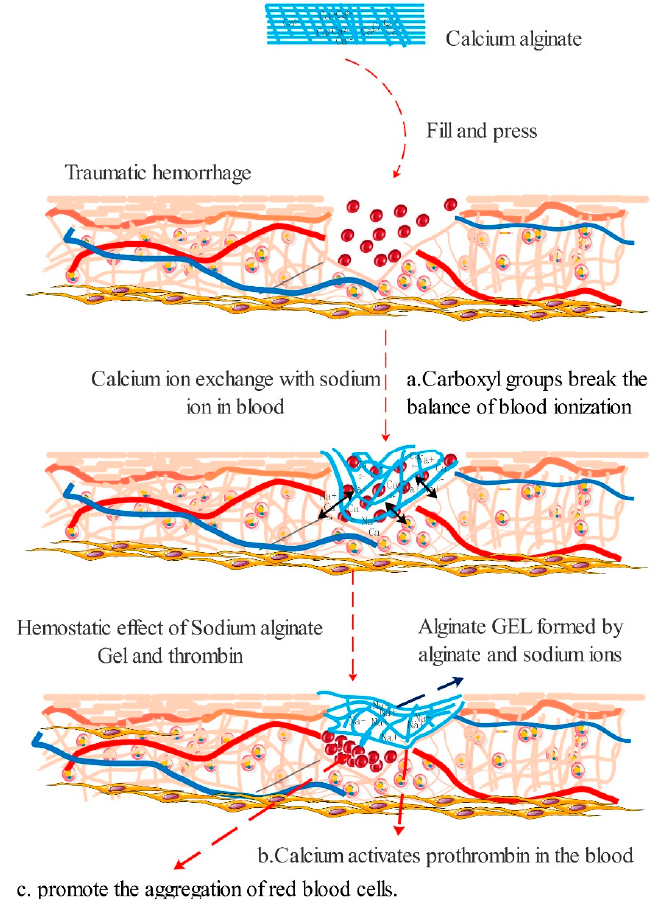
Figure 2. Hemostatic mechanism of calcium alginate fibers. ( a ) Carboxyl groups break the balance of blood ionization. ( b ) Calcium ions activate prothrombin ( c ) promote the aggregation of red blood cells.